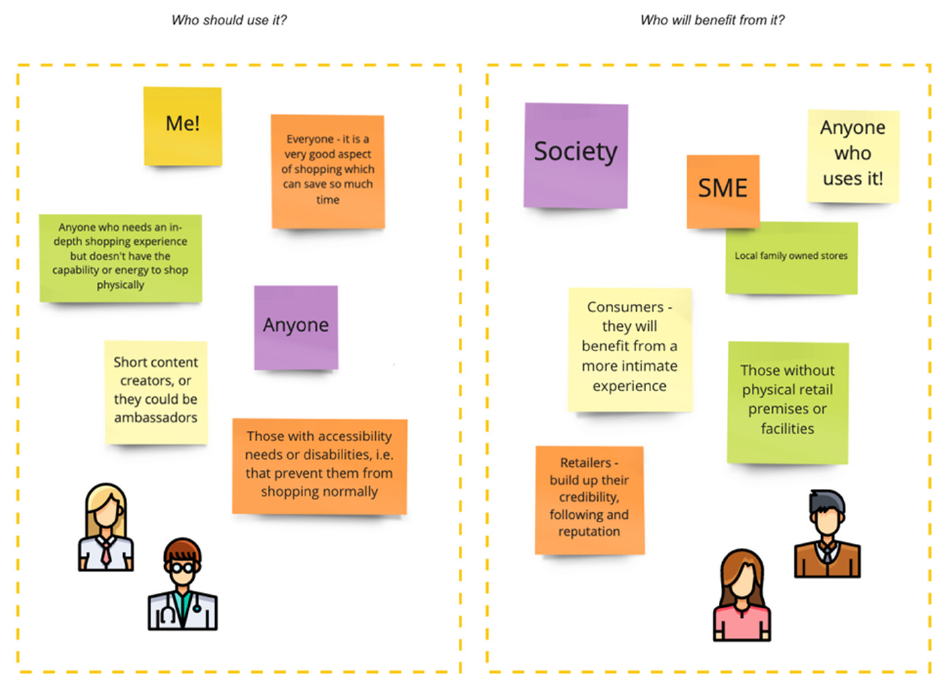
Figure 9. A screenshot from the Participatory Design Workshop Miro board, illustrating who should use live stream retailing and who would benefit from it. use live stream retailing and who would benefit from